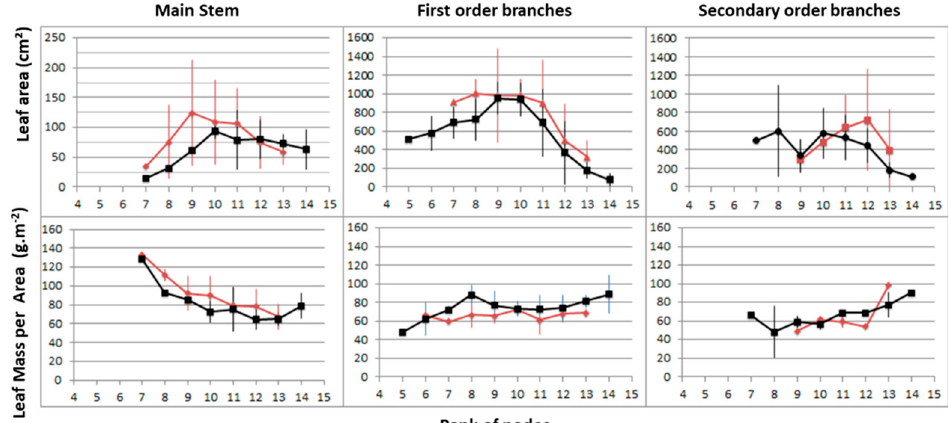
Figure 8. Pattern of variation in individual leaf area (upper part) and leaf mass per area (lower part) according to the node rank at the time of collection (15 May) in Control—(black) and FR-treated—(brown) plants (n = 3 or 4). Leaves of the main stem from nodes 1 to 4 had fallen before the day of collection.